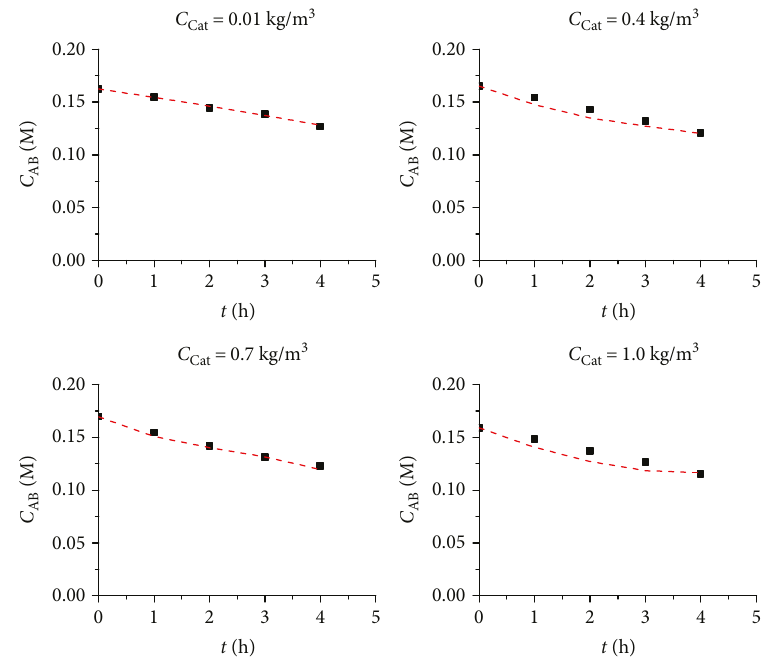
Figure 13: Comparison of experimental concentration pro fi les (dots) with those obtained by the proposed